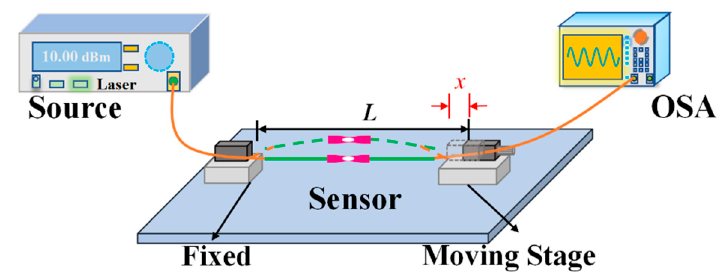
Figure 4. Experimental system for bending sensing.